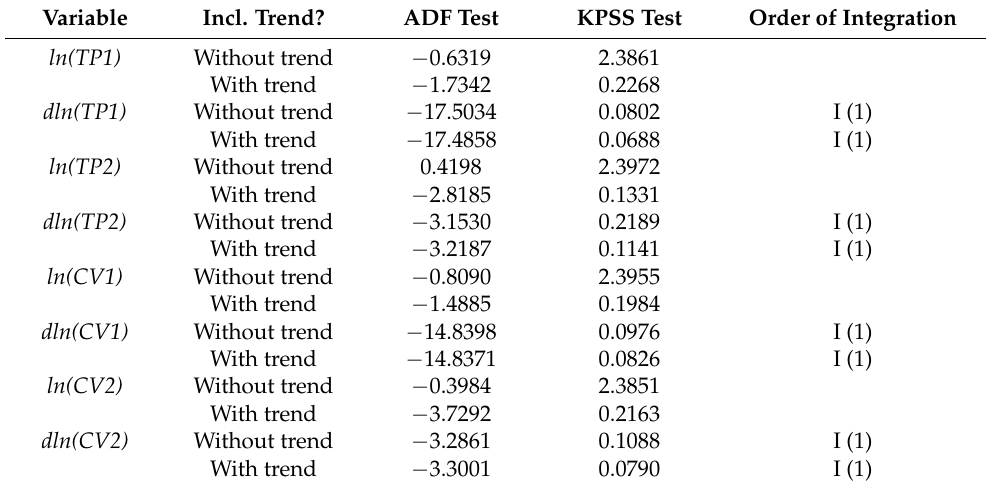
Table 2. The result of the Unit root test.